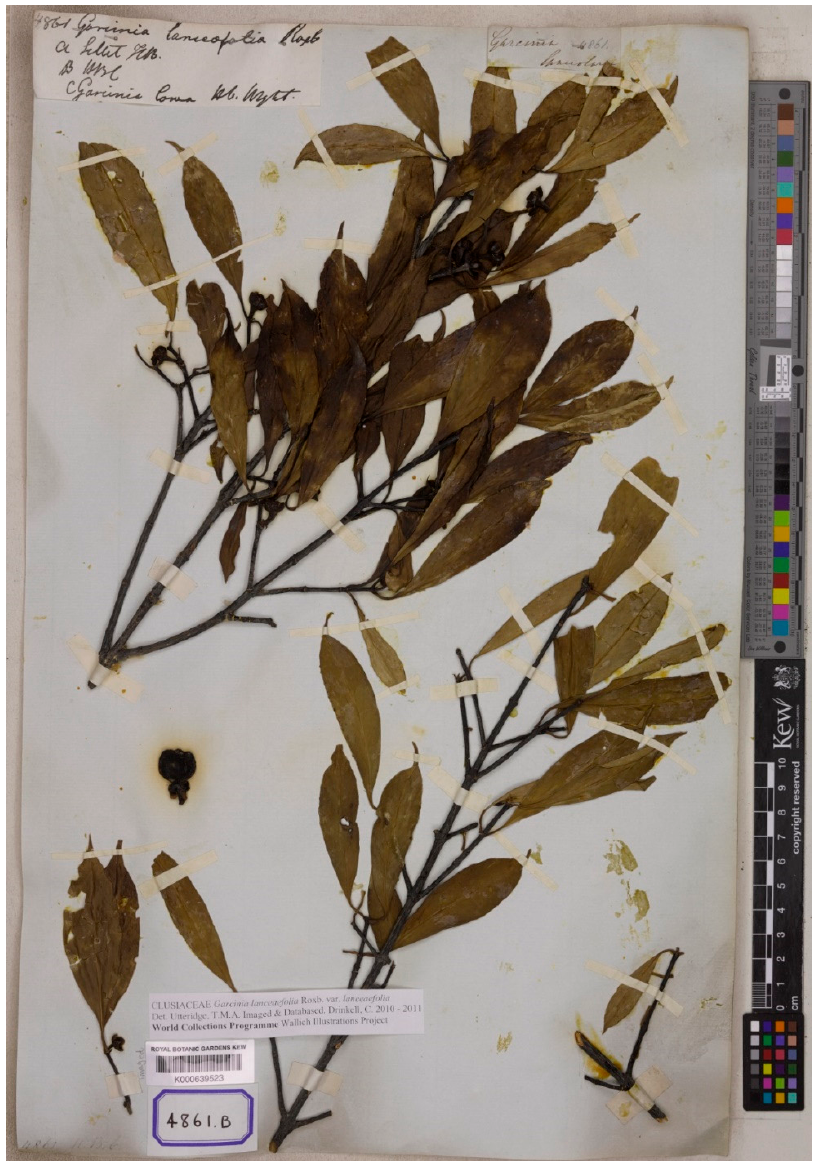
Figure 5. Lectotype of Garcinia lanceifolia , Unknown collector , East India Company Herbarium 4861B (K- W [K000639523!]) from India, cultivated in H.B.C. (Calcutta Botanical Garden), with female flowers and young fruits (http://specimens.kew.org/herbarium/K000639523, accessed on 16 February 2022). Garcinia gracilis Pierre (Pierre, 1882) [14]: 260; [17]: 115; [19]: 353, fig. 543; [38]: 563, fig. 1557; [44]: t. 63; [46]: 301; [51]: 19. t. 142,143. Type: Cambodia, Ad flumen Se Kemoun, male fl., Jan. 1877, Harmand 3618 (lectotype P [P04701635!], isolectotype P [P04701631!], designated here) (Figure